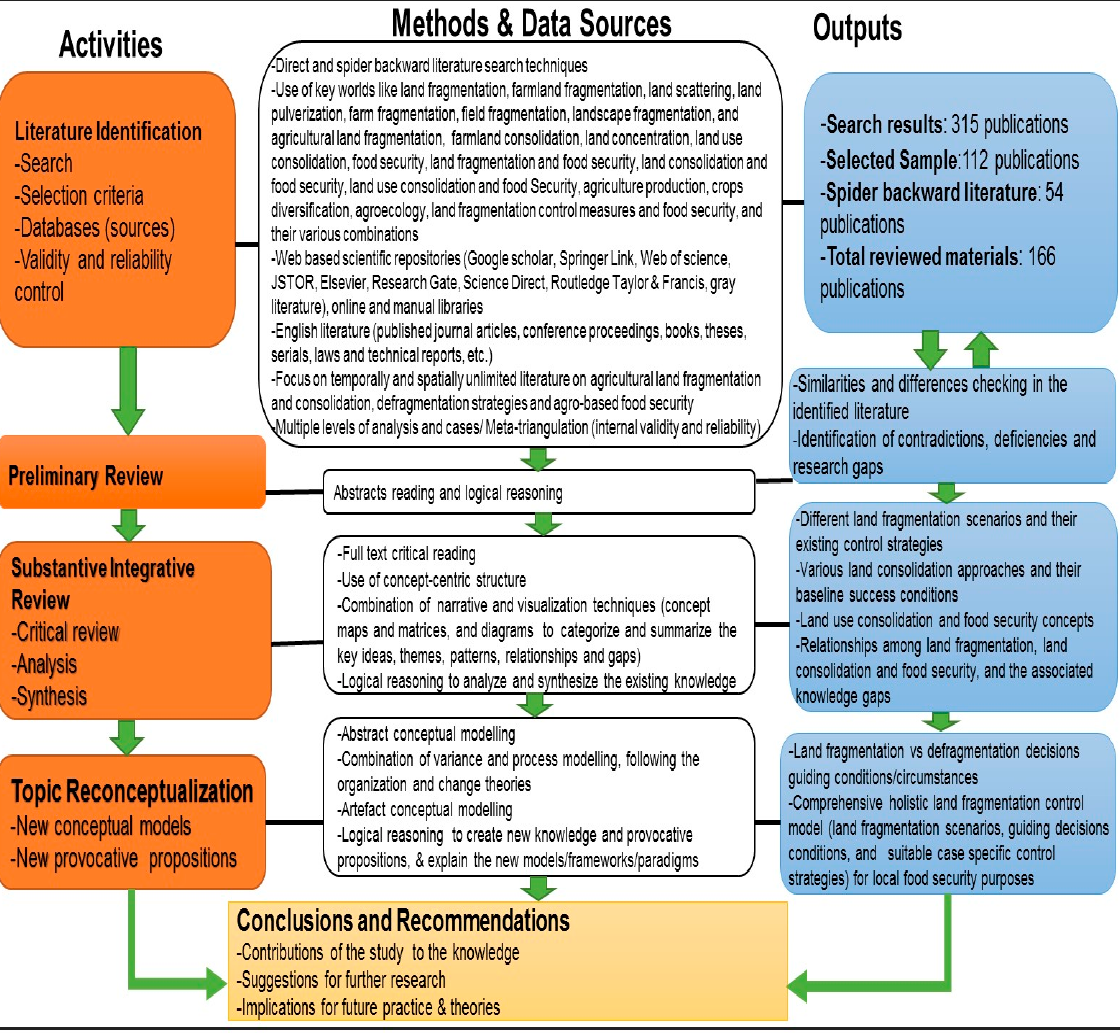
Figure 1. Overview of the research process and design. Source : Adapted from Ntihinyurwa and de Vries [11] and Ntihinyurwa and de Vries [75].